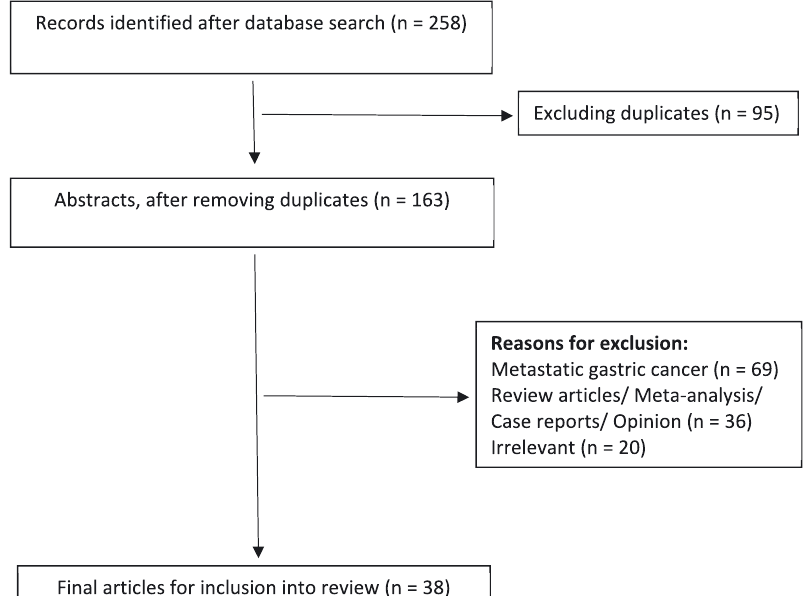
Figure 1: Flowchart for literature